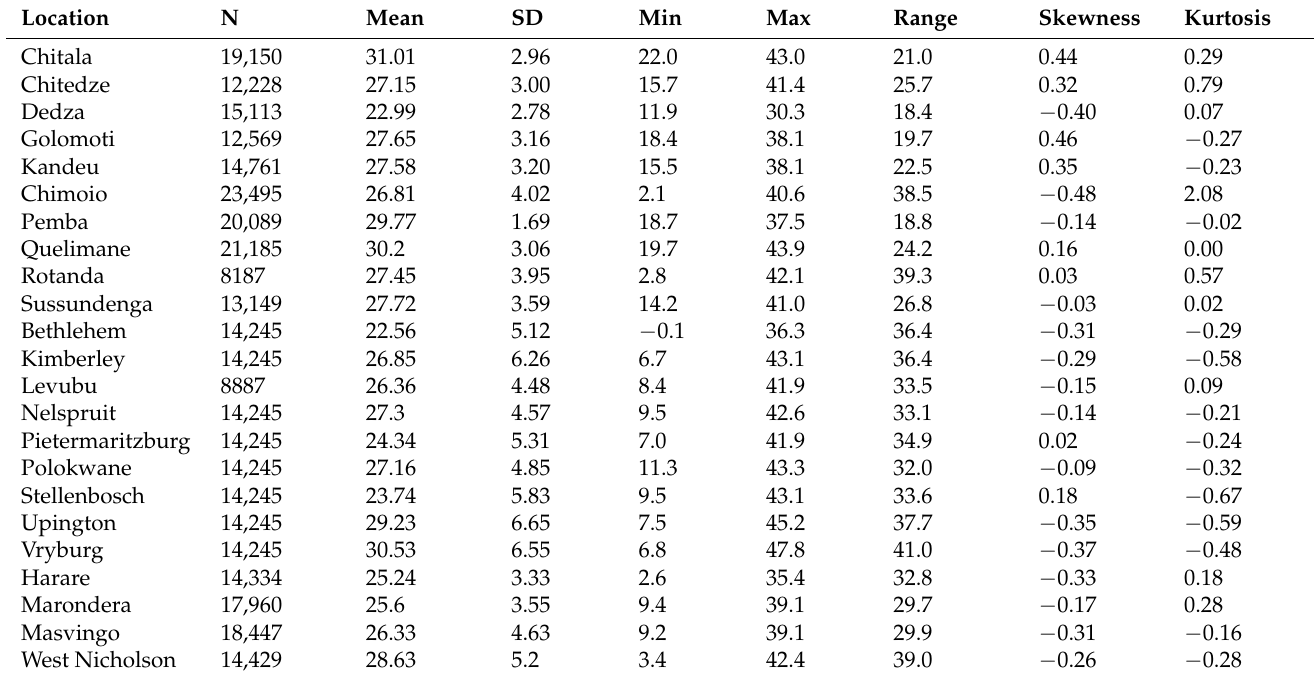
Table 2. Descriptive statistics for maximum temperatures measured at each of the meteorological stations in the four countries.